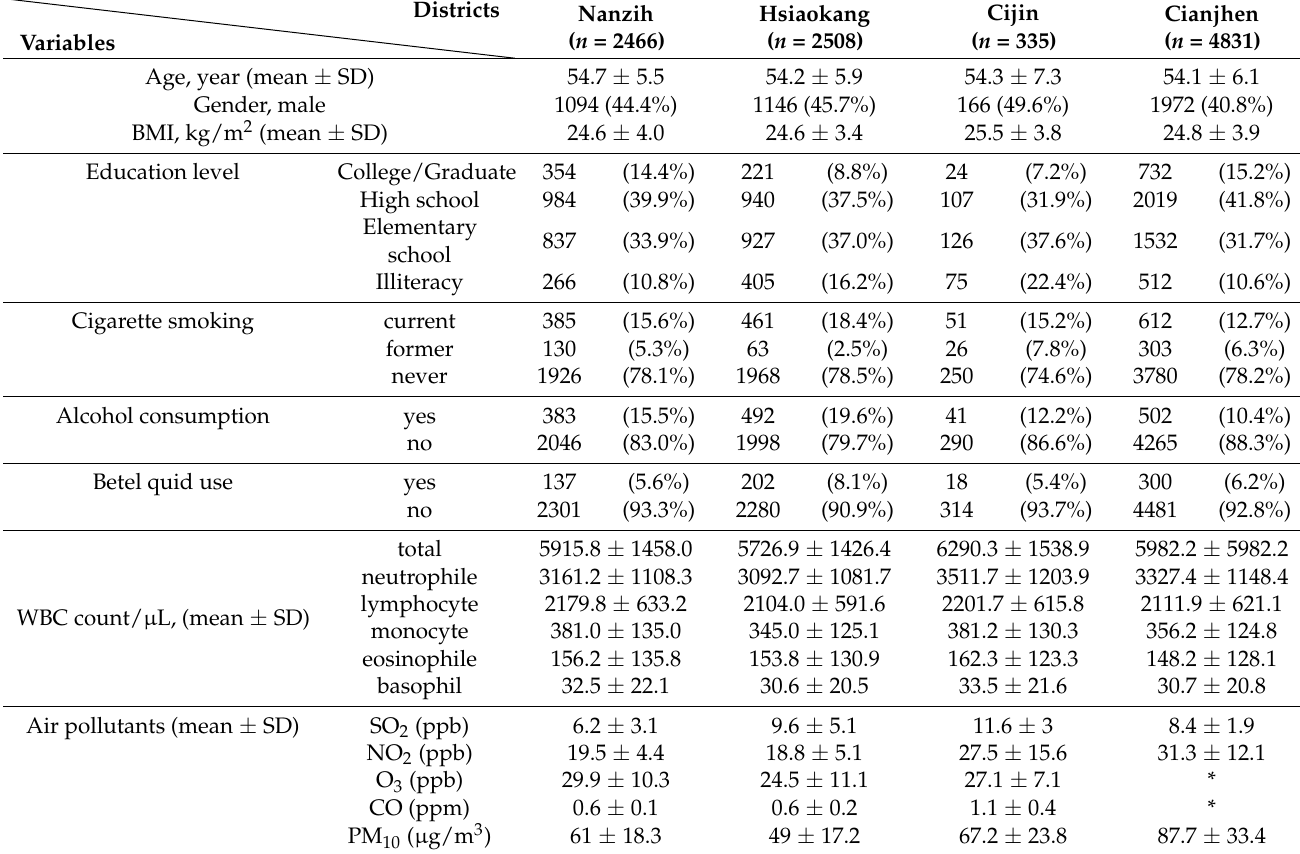
Table 1. Demographic characteristics of participants and WBC counts in study districts.